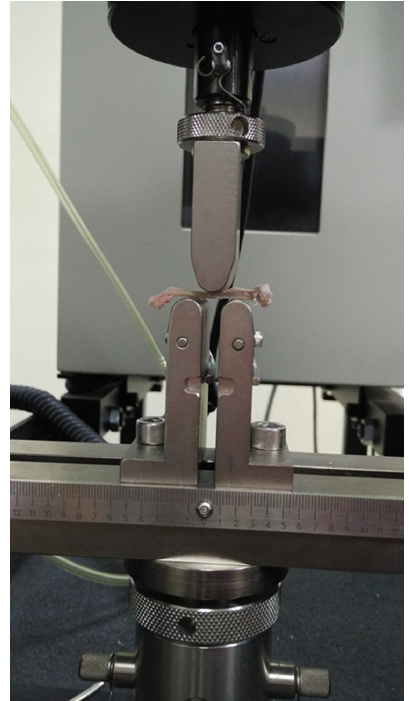
Figure 1. Biomechanical strength test on the femur.